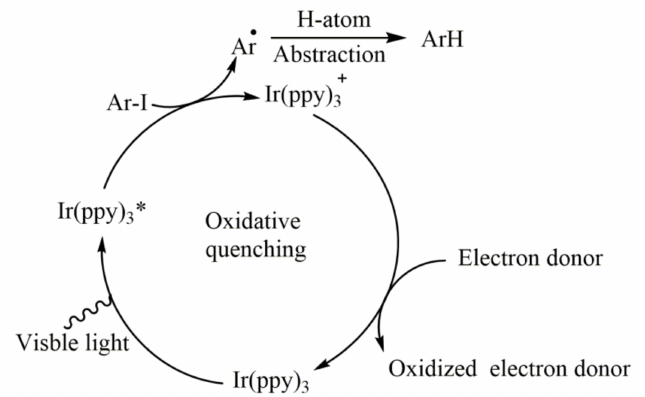
Figure 3. The mechanism of visible-light-driven aryl iodide reduction with fac -Ir(ppy) 3 as photosen- sitizer. Reprinted with permission from Ref. [18]. Copyright 2012, Nature Publishing